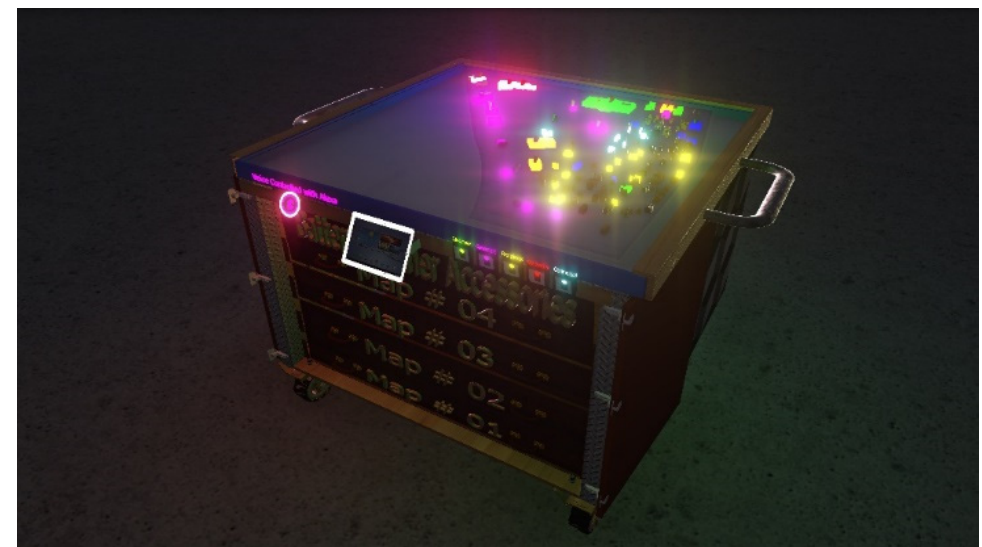
Figure 8. An MMS at night.